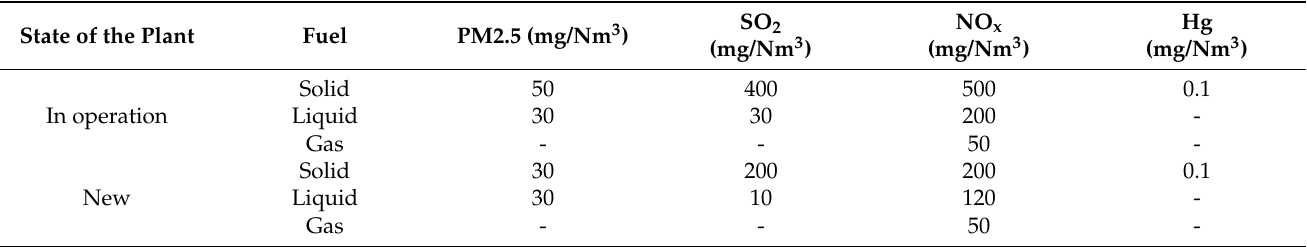
Table 4. Emission limit values in Chile, according DS N ◦ 13/2011 [59]. PM2.5: particulate matter 2.5. State of the